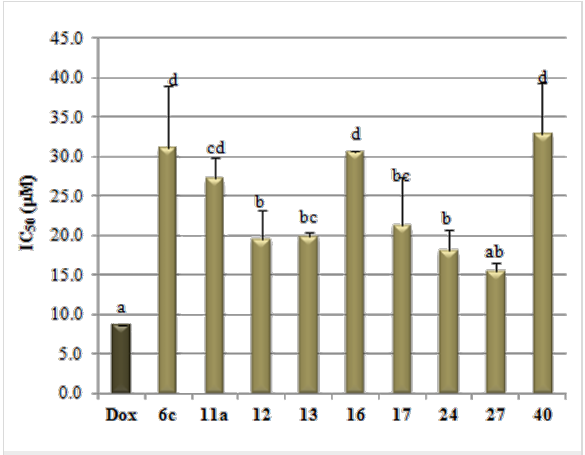
Figure 3: Cytotoxicity effect of some new cholesterol derivatives on the PC3 cell line. Doxorubicin (Dox) was used as positive control. Different letters on the column varied significantly at p ≤